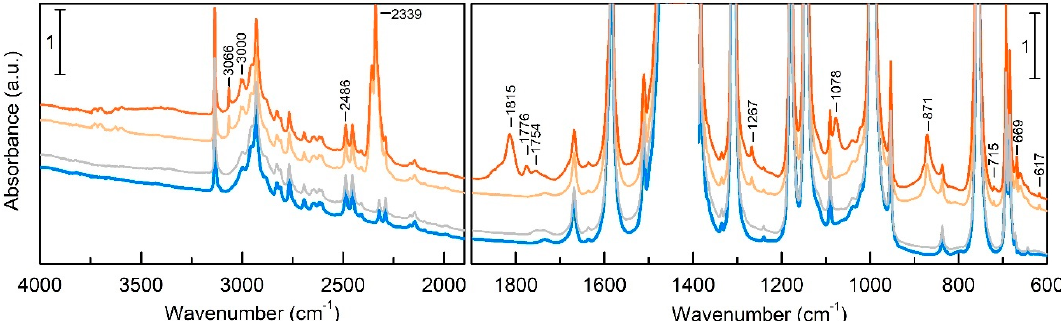
Figure 4. Fourier transform infrared (FTIR) spectrum of ZIF-8 degassed at 300 °C ( blue curve ). On this sample, a gas mixture of 150 mbar of EtO and 600 mbar of CO 2 was dosed at 35–40 °C ( light orange curve ) and left in contact with the sample for 4 days ( orange curve ). The spectrum after degassing at beam temperature for 15 h is reported as a grey line.